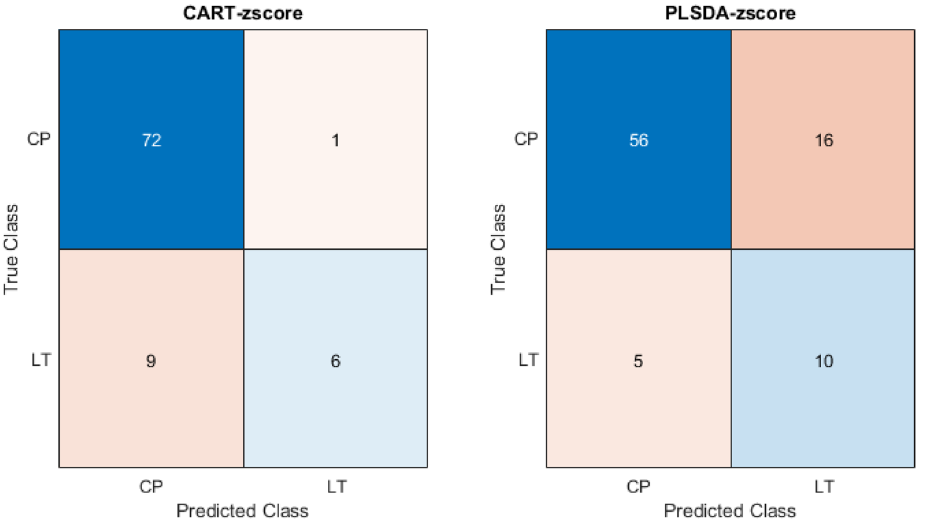
Figure 3. The confusion matrix of CART and PLSDA on the electronic nose data.